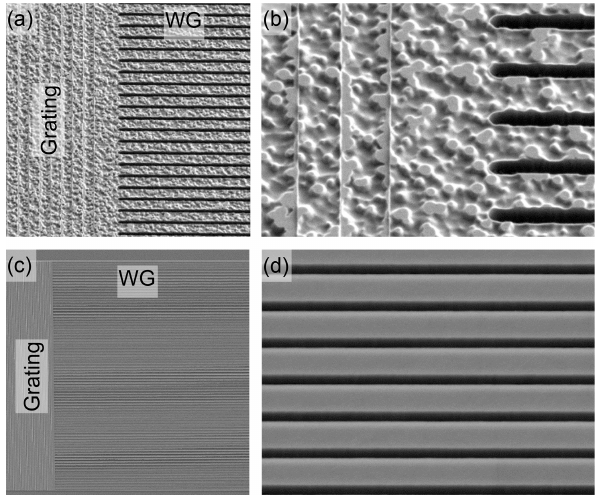
Figure 6. SEM images of unprotected and protected waveguide structures after the AlN dry-etching process. (a) The unprotected polysilicon appears very rough. The coupler grating and the waveg- uide area is visibly harmed. (b) Magnified view of a coupler grat- ing to waveguide transition. (c) Protected structures, after removal of the residuals of the sacrificial oxide layer, taken form the wafer center. These samples do not show much damage, as revealed by the magnified view in panel (d) . All SEM images are taken with a tilt of 30 ◦ .